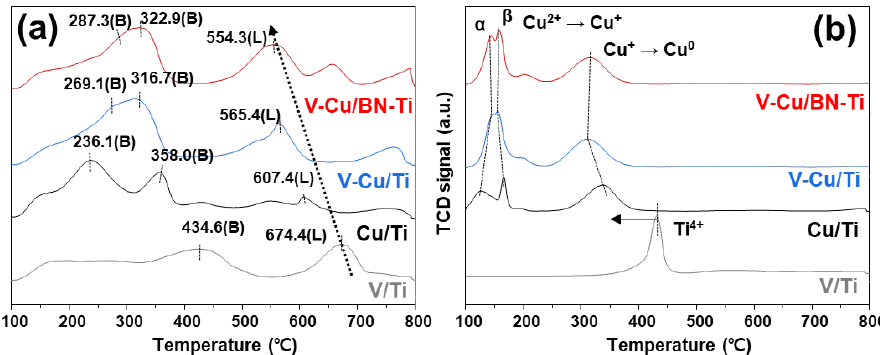
Figure 4. ( a ) NH 3 -TPD and ( b ) H 2 -TPR profiles for V/Ti (gray line), Cu/Ti (black line), V-Cu/Ti (blue line), and V-Cu/BN-Ti (red line). Table 2. NH 3 desorption and H 2 consumption with regard to the acidity properties of the synthe- sized